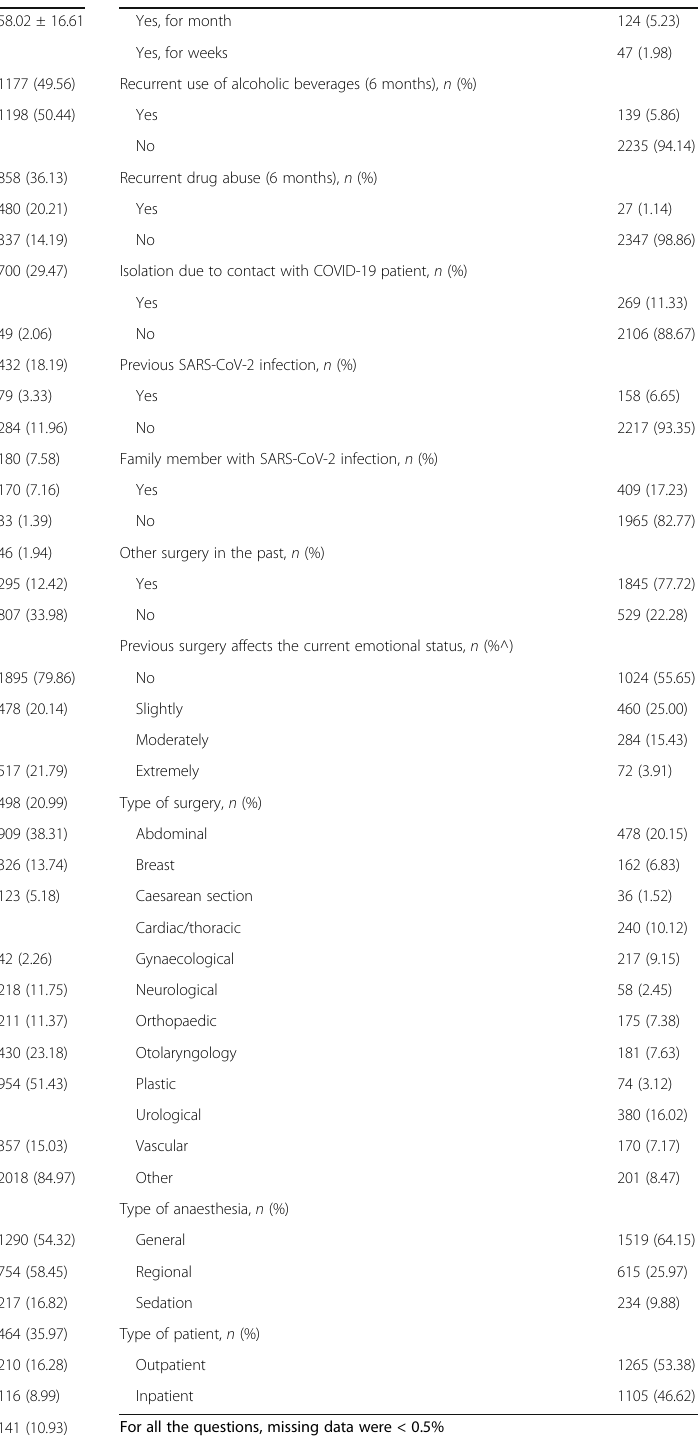
Table 1 Characteristics of the surveyed